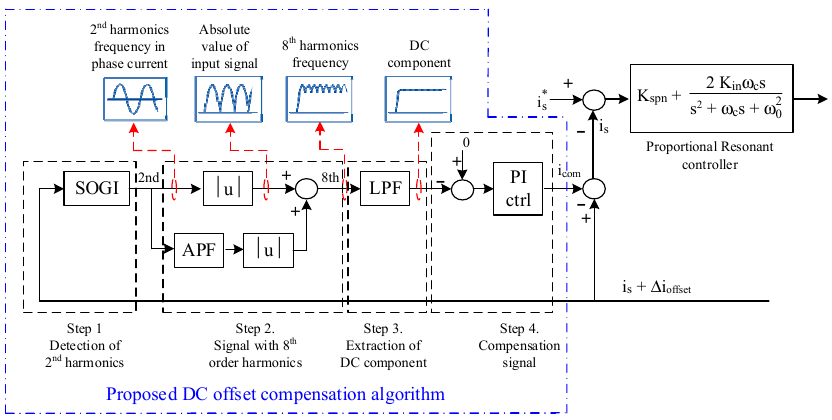
Figure 3. A block diagram of a single-phase grid-tied control system containing the proposed DC offset error compensation algorithm.